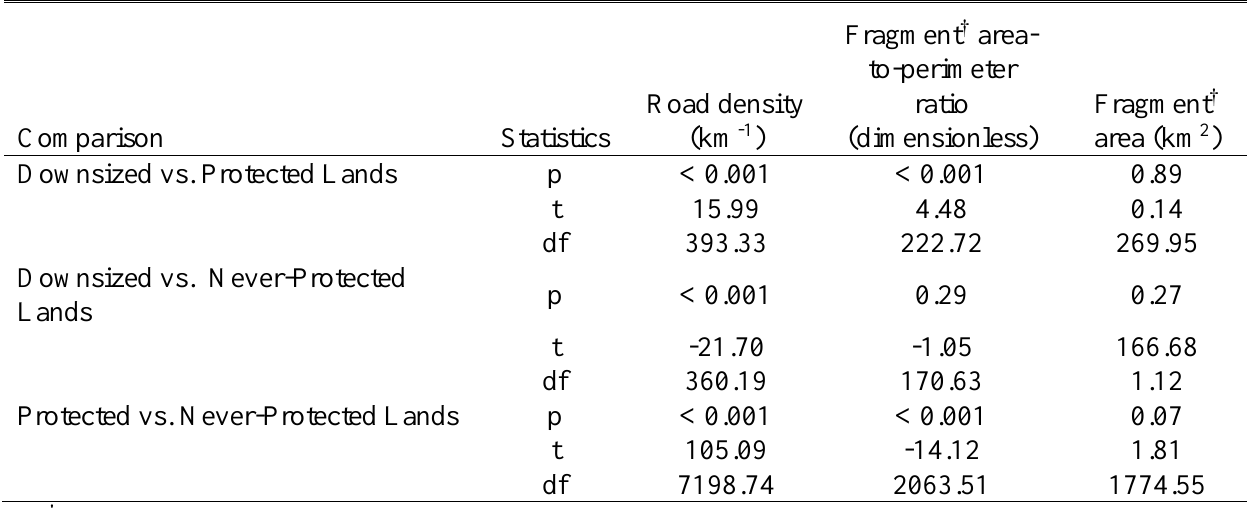
Table A1.7: Habitat fragmentation at the Ecoregional scale for forested lands – post-hoc tests results of Welch’s t-tests from Table